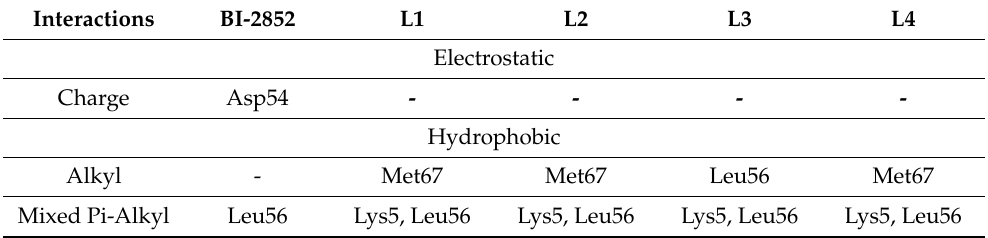
Table 5. Intermolecular electrostatic and hydrophobic interactions of 4 lead flavonoids.